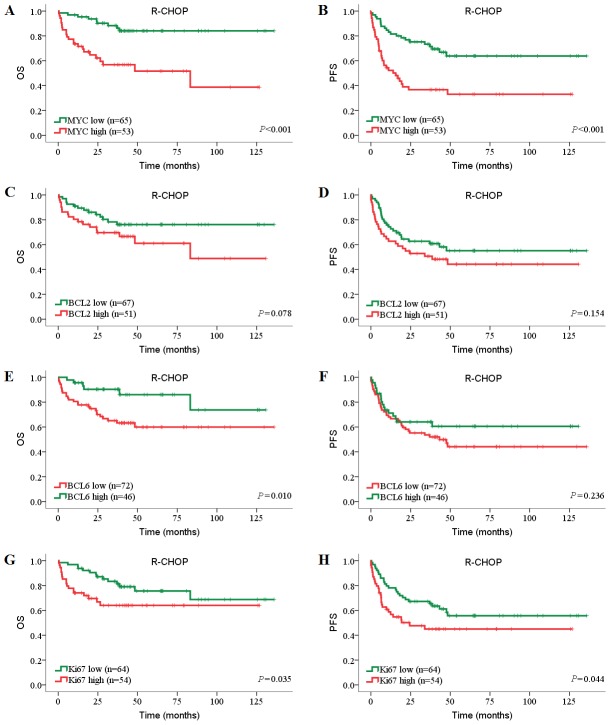
Prognostic impact of MYC, BCL2, BCL6 and Ki67 expression in DLBCL patients treated with R-CHOP.Patients’ tumors were stained for (A, B) MYC, (C, D) BCL2, (E, F) BCL6, and (G, H) Ki67. The numbers of patients showing negative or positive stainings (MYC≥40%, BCL2≥70%, BCL6≥50%, Ki67≥90%), cut-off values, and P values are indicated.